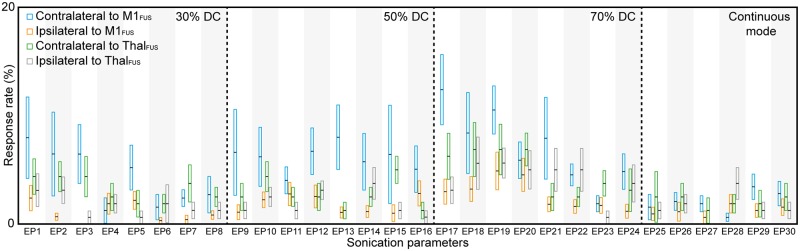
Results of excitatory sonication to the M1 and thalamus (Thal).The group-averaged EMG response rates (with standard error bars) measured from bilateral hind limbs for sonication parameters EP1–EP30 (see Table 1), evaluated across ten sheep (8800 sonication trials for the M1 stimulation and 4800 trials for the thalamic stimulation). The box indicates the range of positive and negative standard error, and the black horizontal line in the box indicates the average value.